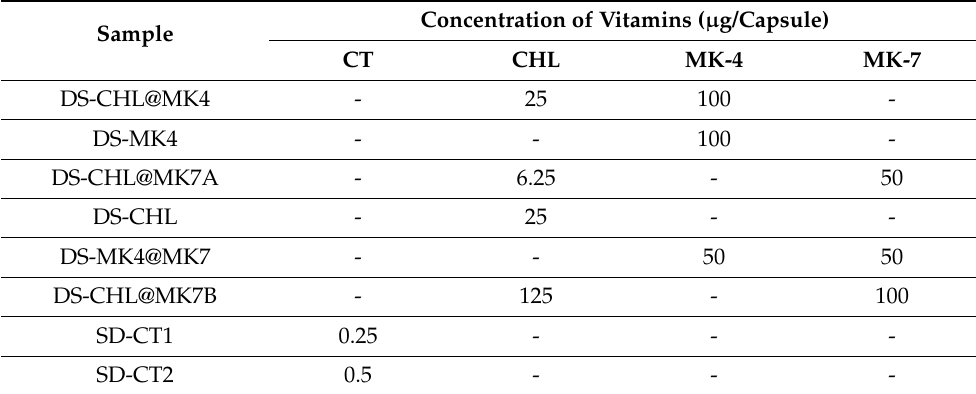
Table 9. Dietary supplements and synthetic drugs analyzed (capsule